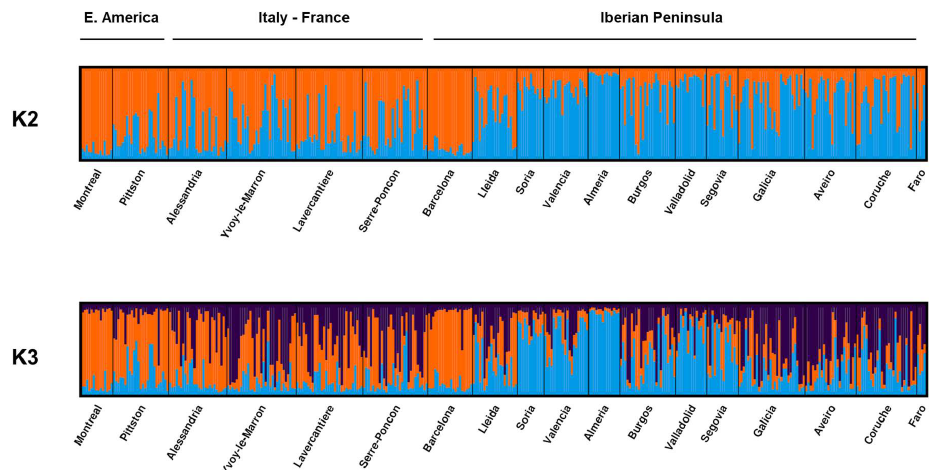
Figure 3. Graphical representation of Leptoglossus occidentalis population genetic structure estimated using a Bayesian clustering approach implemented in STRUCTURE for K = 2, the best K was determined by the Evanno method, and K = 3. The populations from eastern North America (E. America), Italy, France, Barcelona, and Valencia in Spain were incorporated into the dataset from Lesieur et al. [13]. Each individual is represented by a vertical line, and each colour represents a particular genetic cluster.